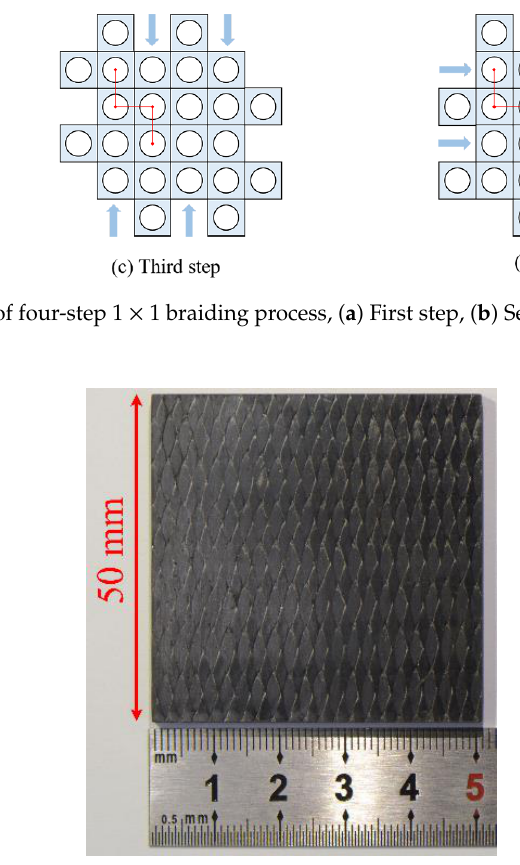
Figure 2. Specimen of 3D four-step braided composite for measuring moisture absorption.